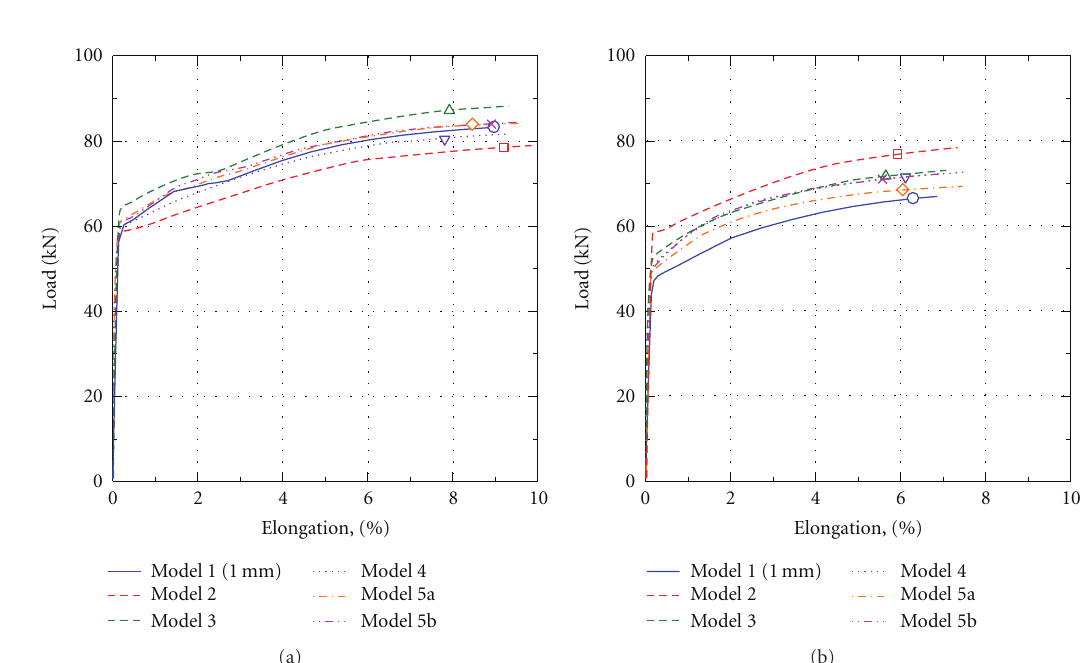
Figure 12: Comparisonof load-elongation curves ofSCSM models: (a)moderate corrosionmember FT-18 and (b) severe corrosionmember